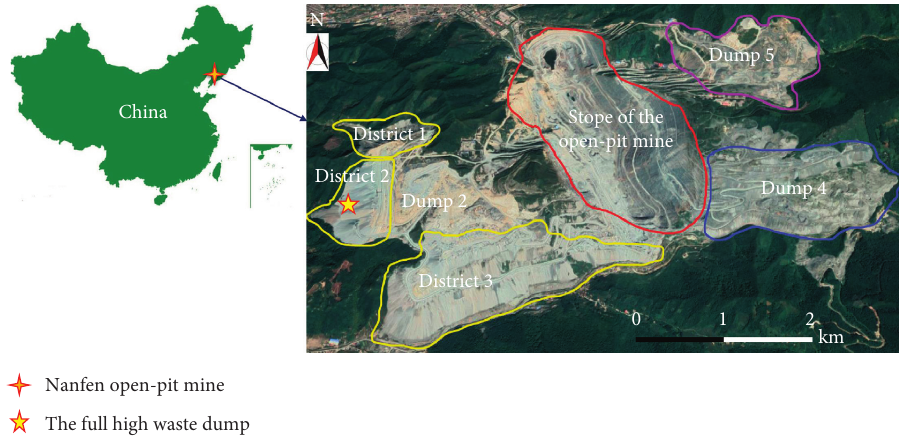
Figure 5: The study area of the landslides for the full high waste dump in